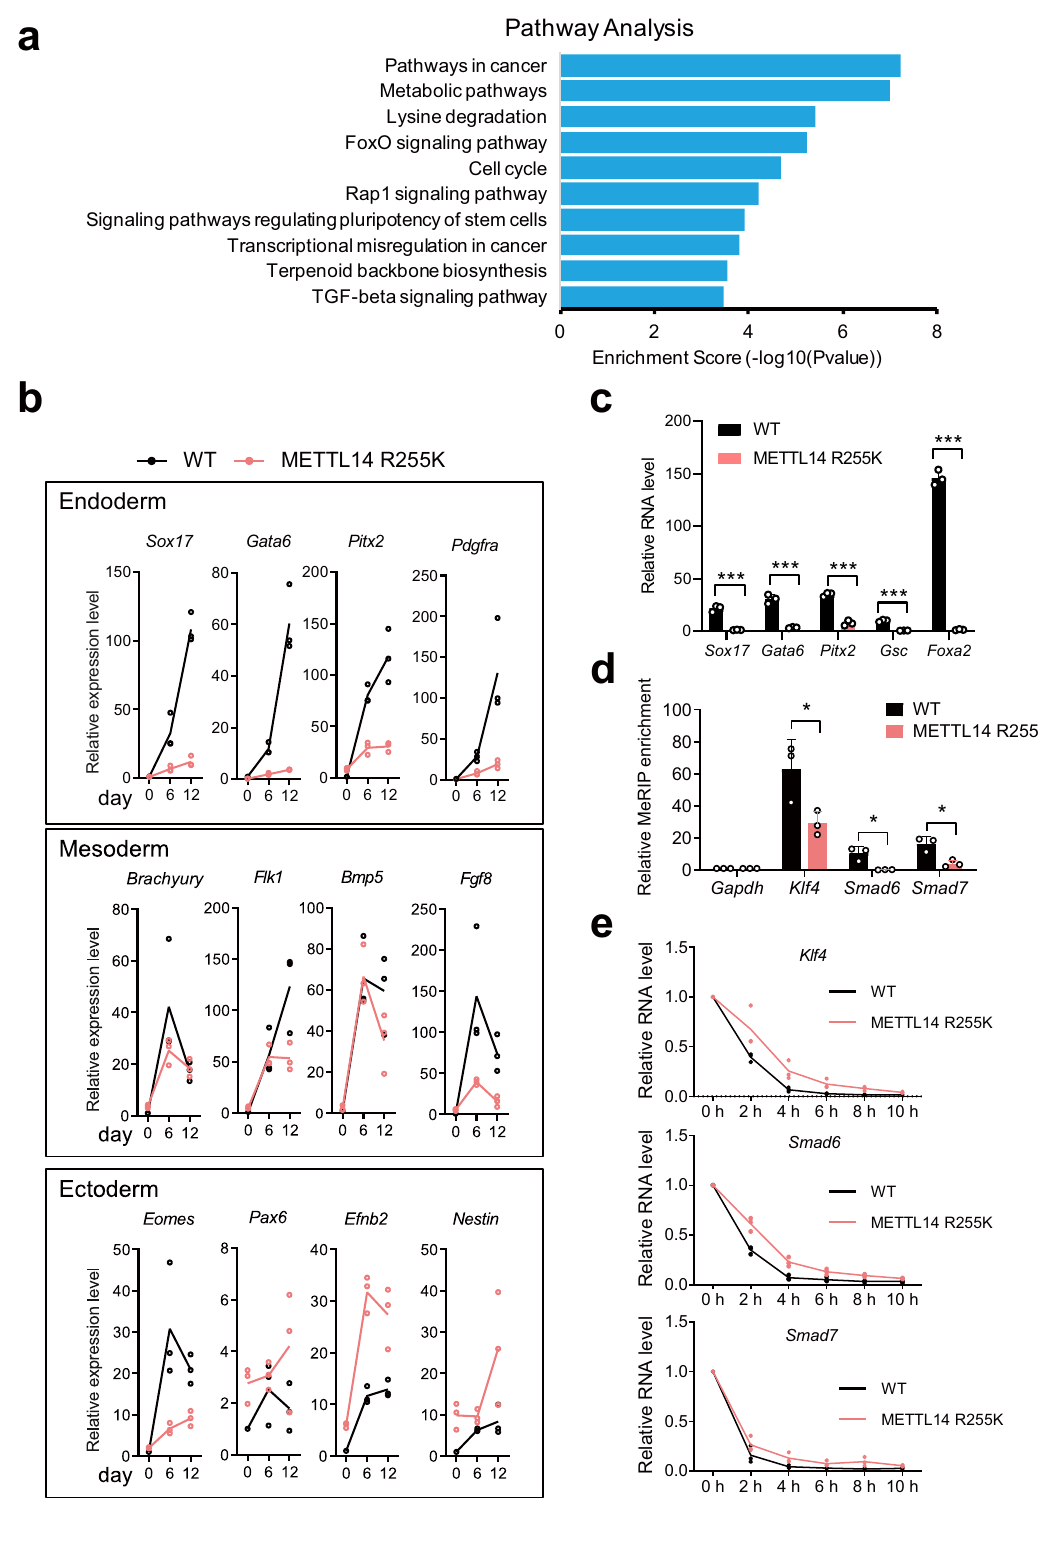
family may be redundantly involved in METTL14 methylation. In the future, it will be interesting to determine context-dependent opment and disease. lation fi ne tunes the regulation of m 6 A methyltransferase